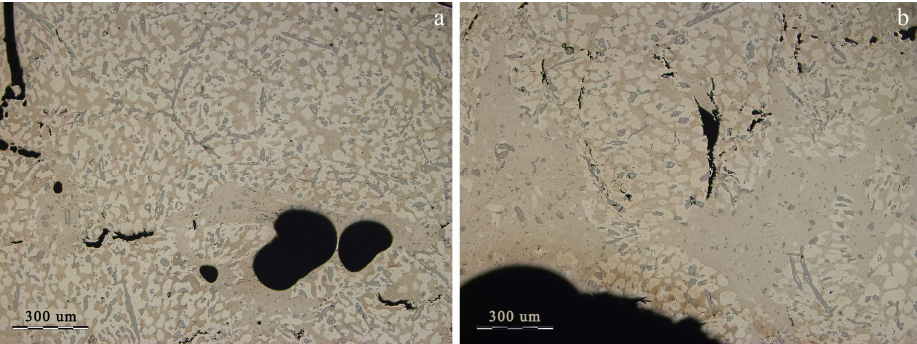
Fig. 4. Structure of the deformed material in the nearest-to-central cavity annular area with fractures localization (а) and material state in the thin layer close to the edge of the central cavity